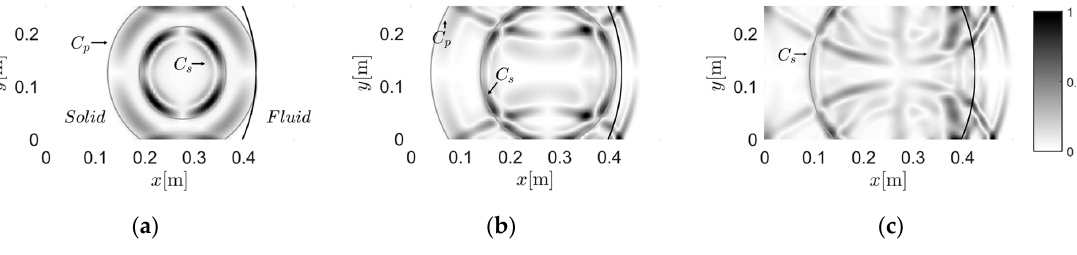
Figure 6. Snapshots of the wavefield induced by the source at 0.275 m and 0.125 m in the solid region: